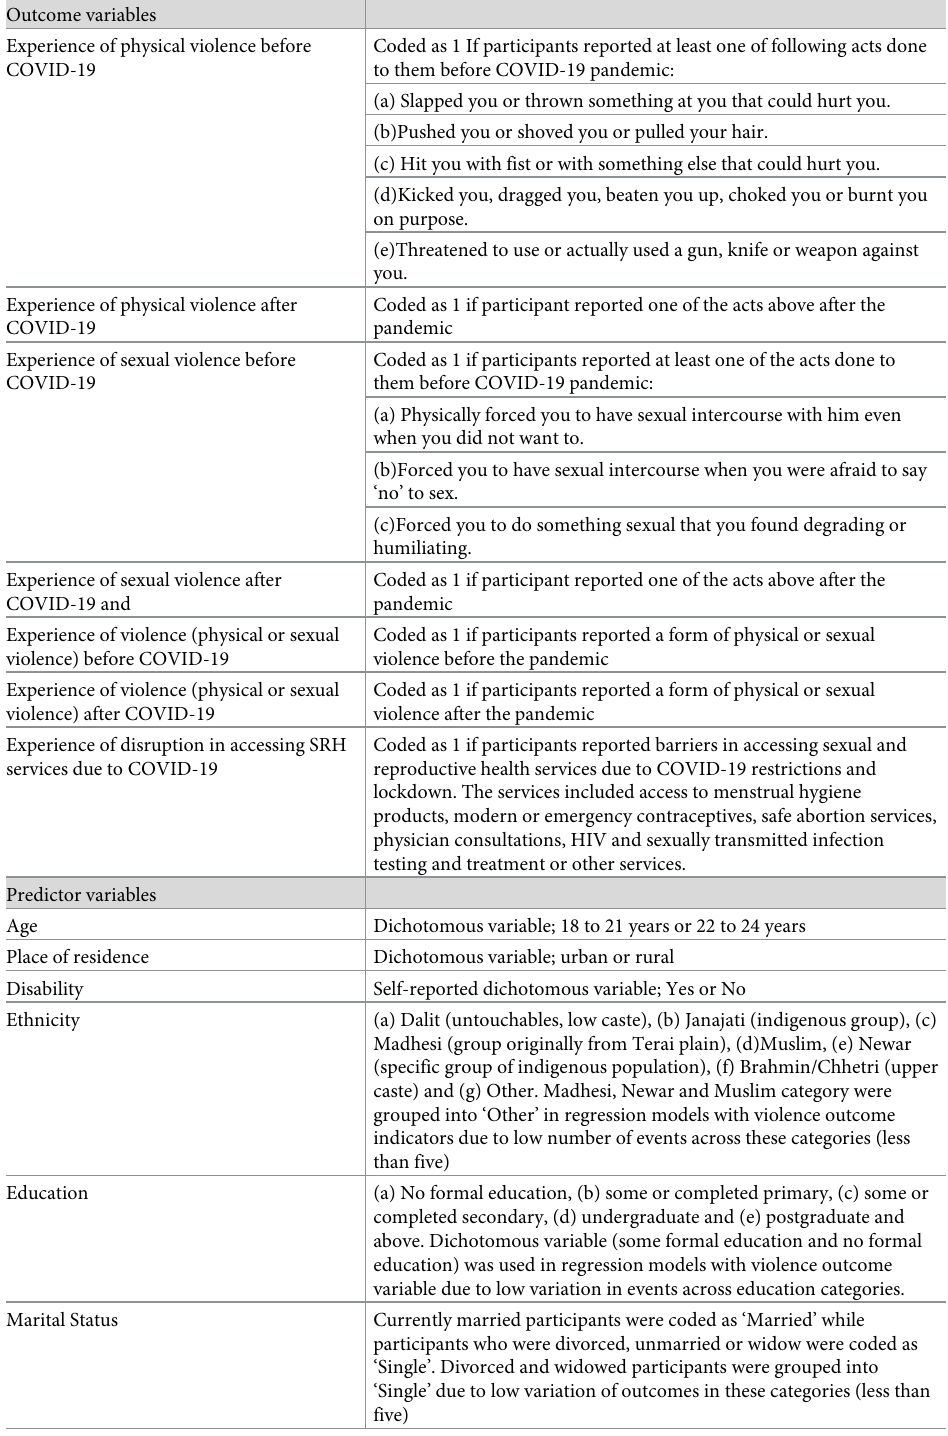
Table 1. List of variables used in the